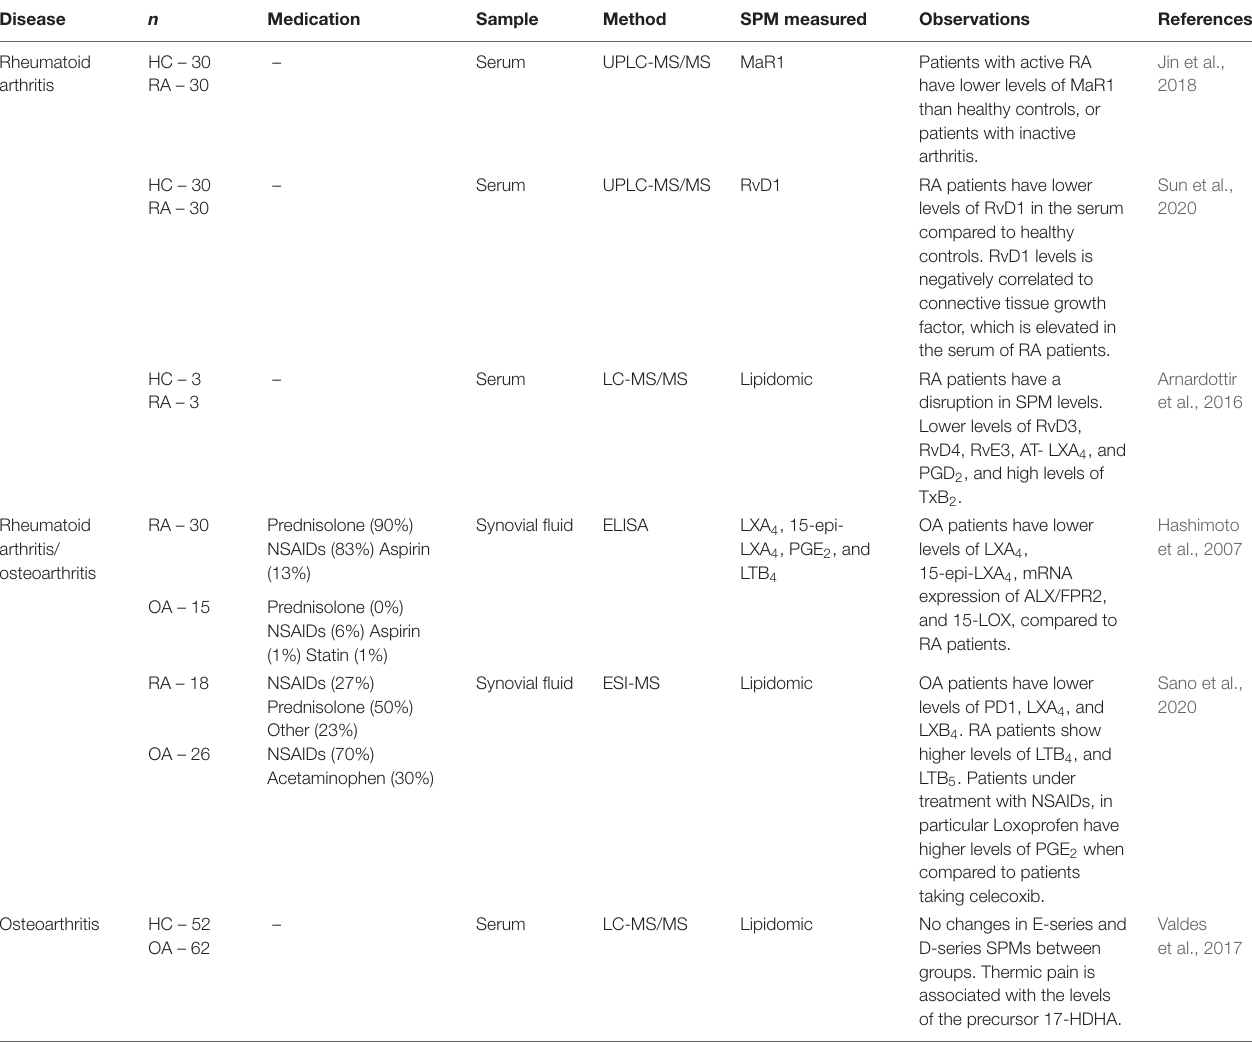
TABLE 2 | SPM and other lipid mediator levels in patients with arthritis and healthy